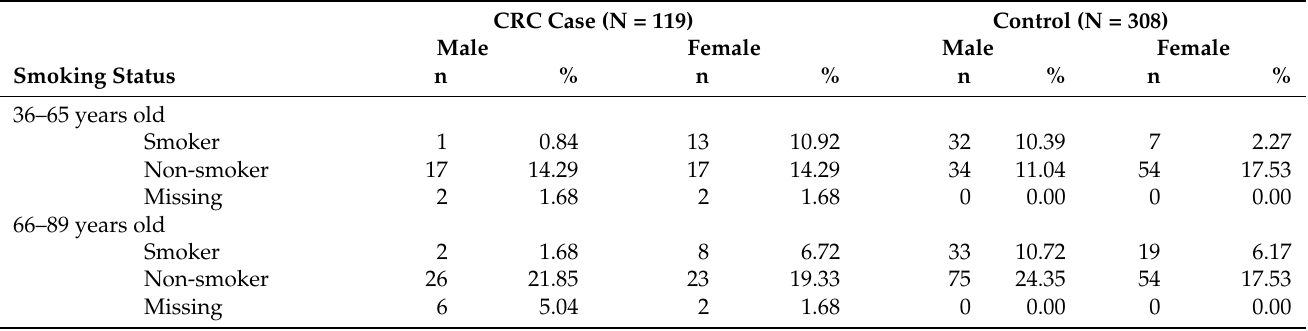
Table 1. Basic demographics of the study sample (N =